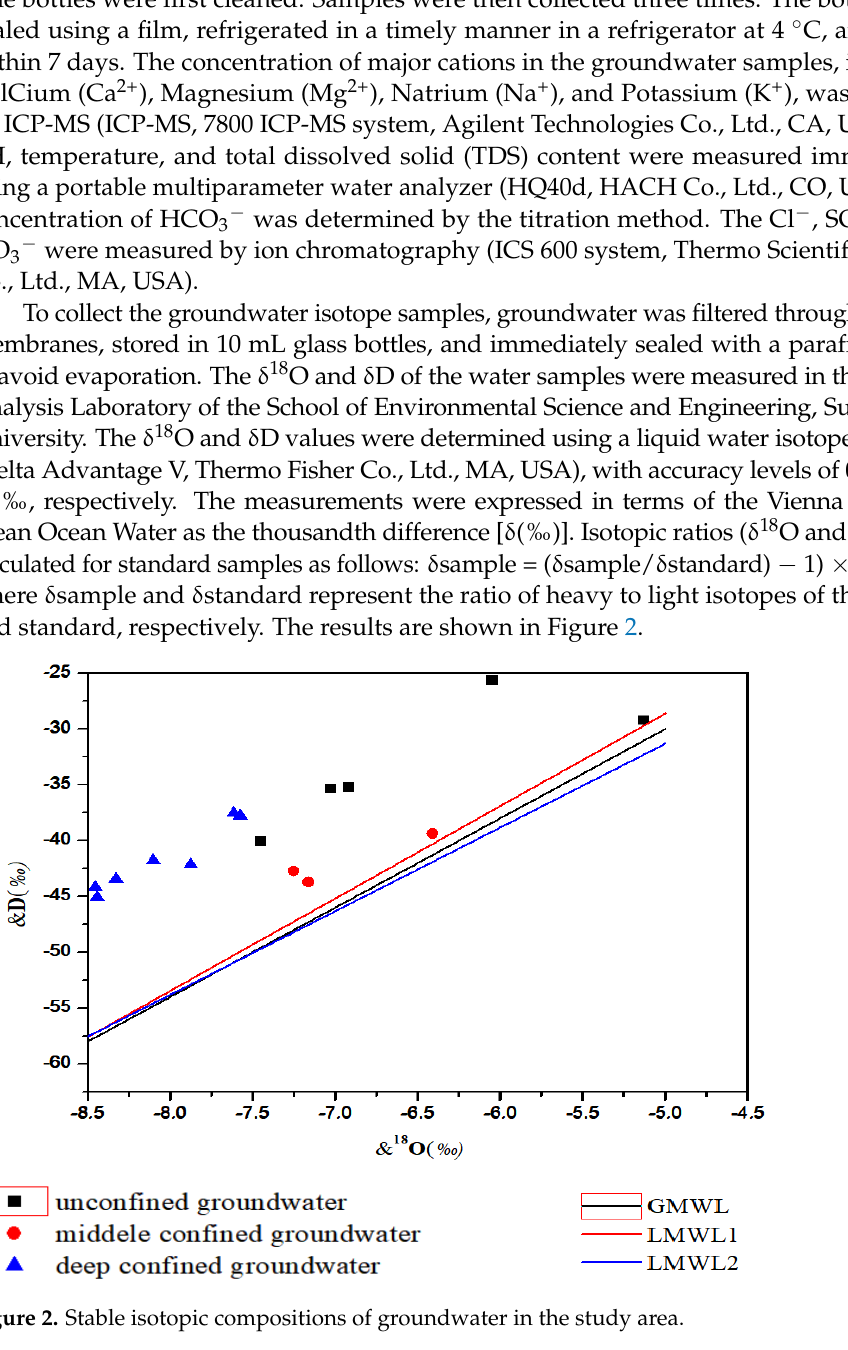
Figure 2. Stable isotopic compositions of groundwater in the study area.